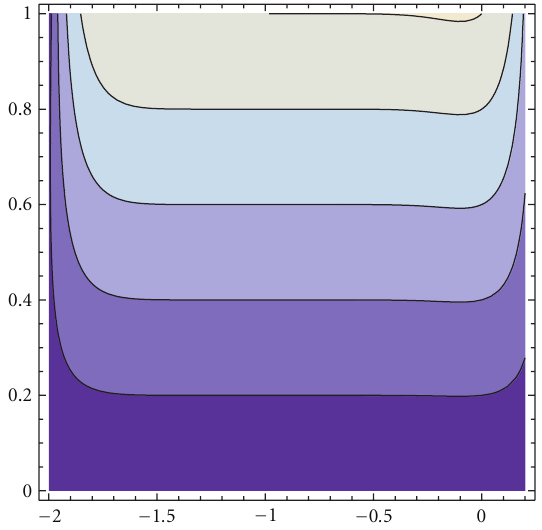
Figure 13: Contour plot of ( ∂/∂t ) G